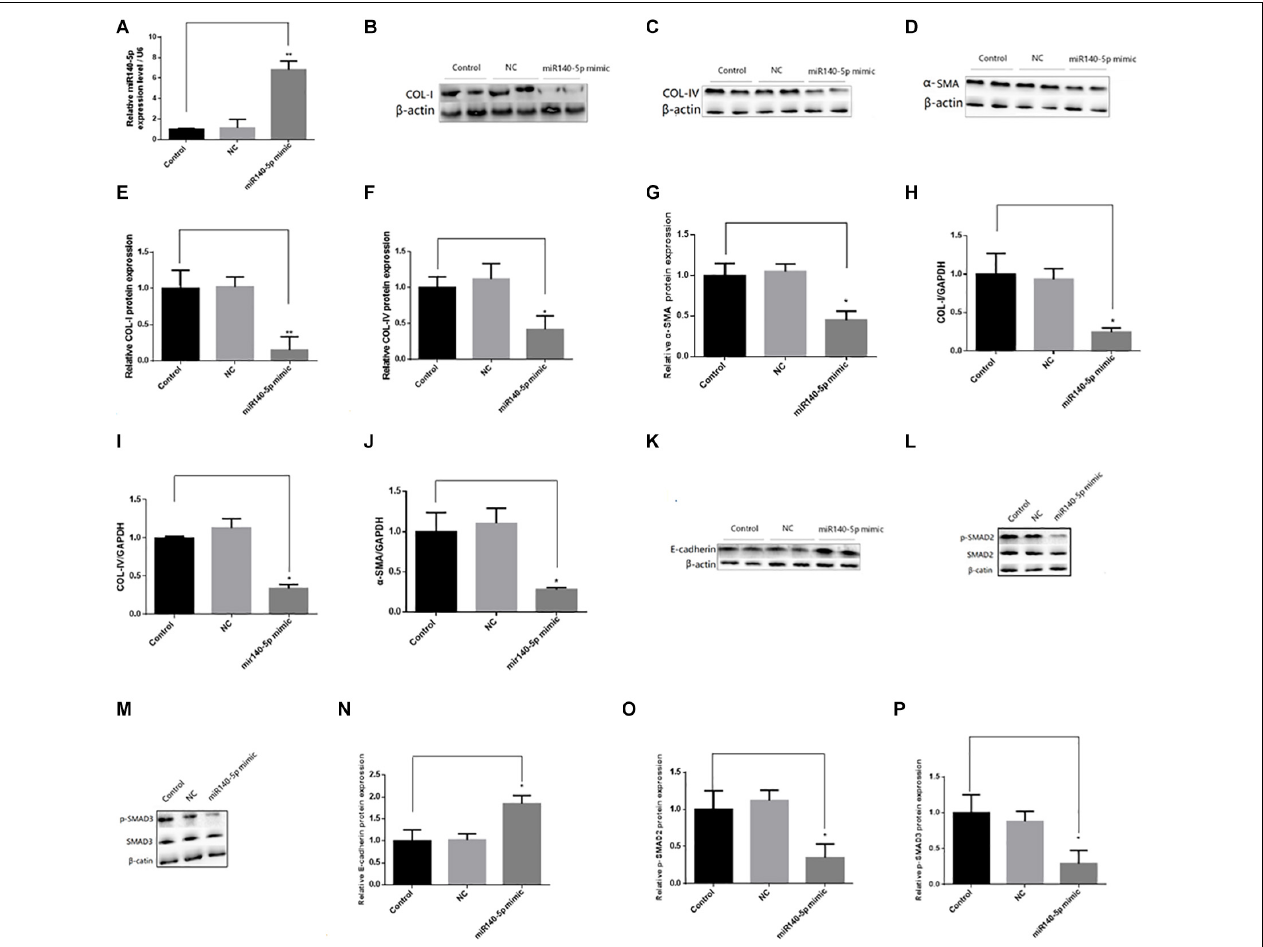
FIGURE 4 | Overexpression of miR140-5p inhibited TGF- β 1-induced fibrosis and EMT in HK2 cells. HK2 cells were transfected with miR140-5p mimic (20 nmol/L) or mimic negative control (NC, 20 nmol/L) for 24 h and then treated with TGF- β 1 (5 ng/ml) for 48 h. (A) the expression level of miR140-5p in HK2 cells transfected with miR140-5p mimic. The protein expression of COL-I (B) , COL-IV (C) , α -SMA (D) were examined by Western blotting in HK2 cells. (E–G) The bar chart showed the ratio of quantitative band density measurements of COL-I, COL-IV, and α -SMA to β -actin, respectively. The mRNA expression of COL-I (H) , COL-IV (I) , and α -SMA (J) were examined by RT-qPCR in HK2 cells. The protein expression of E-cadherin (K) , p-SMAD2/SMAD2 (L) , p-SMAD3/SMAD3 (M) were examined by Western blotting in HK2 cells. β -actin was detected as a loading control. (N–P) The bar chart showed the ratio of quantitative band density measurements of E-cadherin, p-SMAD2, p-SMAD3 to β -actin, respectively. Data was presented as mean ± SD of three experiments. Control: no transfection treatment, Negative control (NC): cells transfected with scrambled oligonucleotide. ∗ P < 0.05 versus Control; ∗∗ P < 0.01 versus